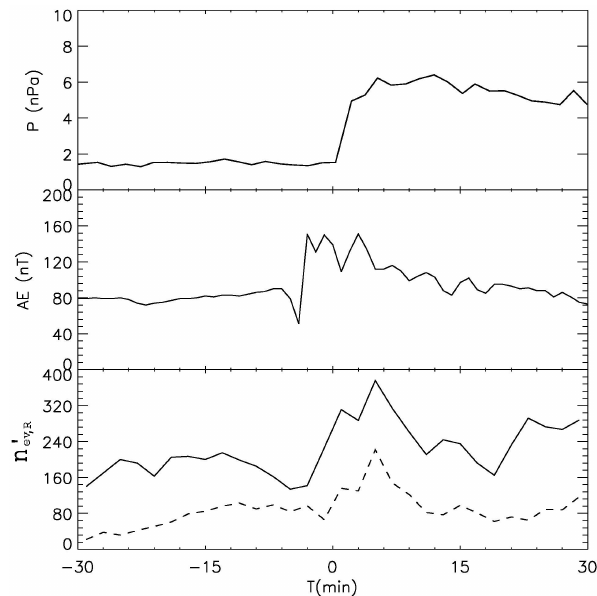
Fig. 2. SI event observed by WIND at 21:00 UT on 20 Febru- ary 2000. From top to bottom: solar wind dynamic pressure mea- sured by WIND, geomagnetic AE index, number of echoes n 0 summed over all beams and ranges for each two-min bin, for the Goose Bay (solid curve) and Kapuskasing (dashed curve) radars. The time axis ranges from − 30 to 30min around the central T = 0 event time, which corresponds to T WIND for the top panel and to T g for the middle and bottom